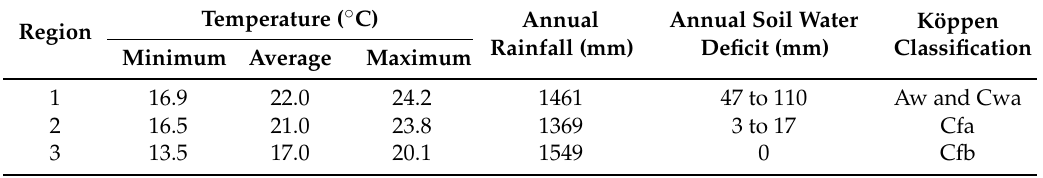
Table 1. Climatic characteristics and classification (Köppen) of the three study regions.